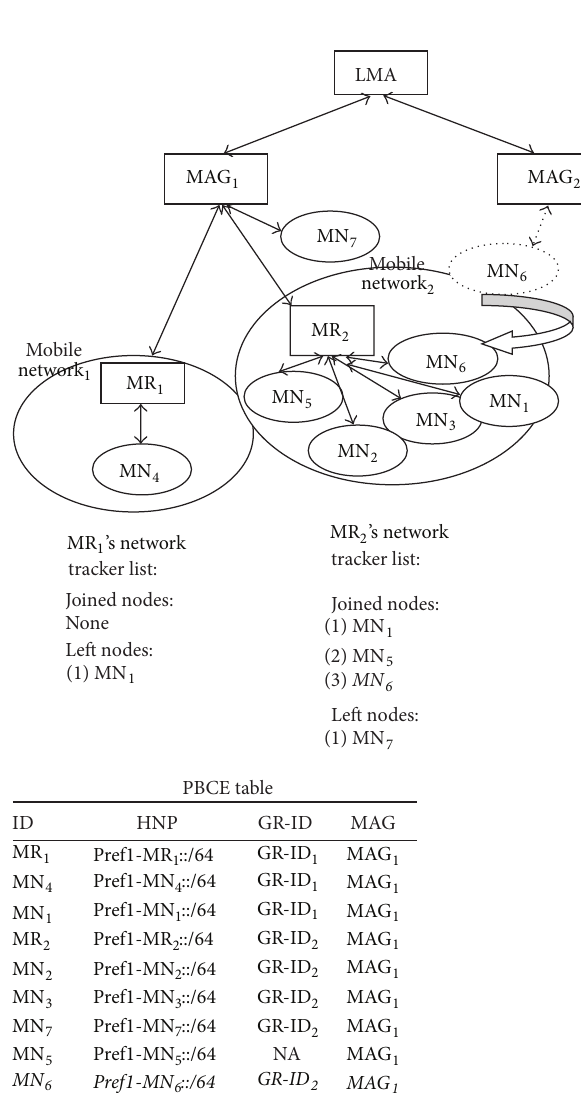
Figure 5: Inter-MAG movement.